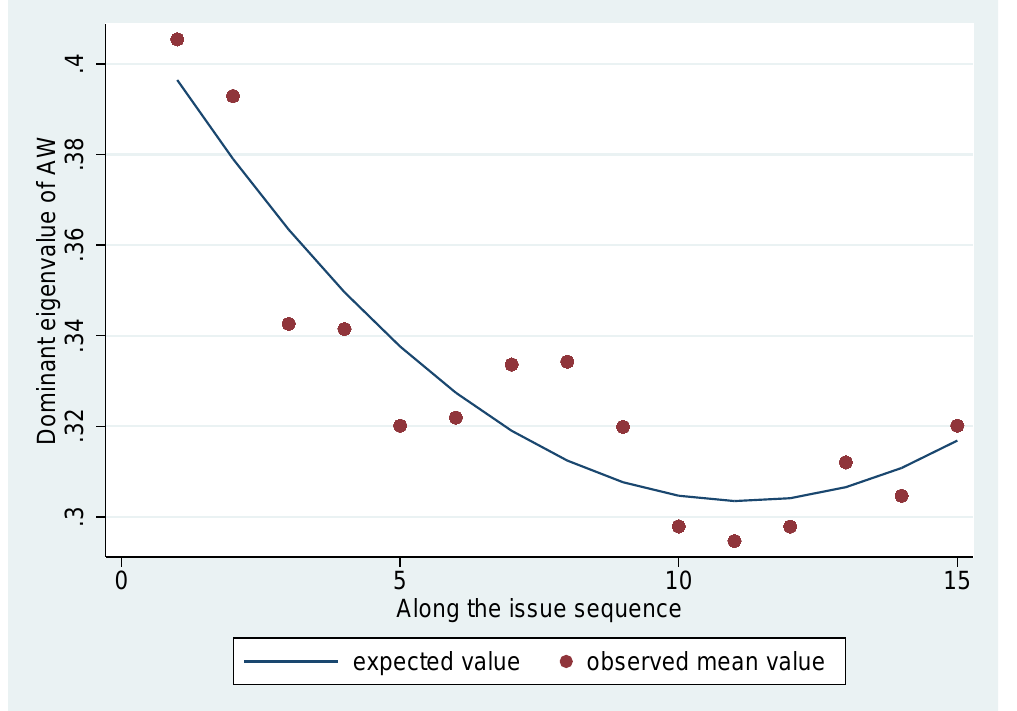
Figure 10: Evolution of the dominant eigenvalue of AW . Balanced random-intercept fixed effects longitudinal design; STATA 12 xtreg implementation; n = 450: plot of expected values based on the estimated β constant = 0.0.416 (s.e. = 0.020), p ≤ 0.001; β s = − 0.020 (s.e. = 0.006), p ≤ 0.001, β R-square (overall)